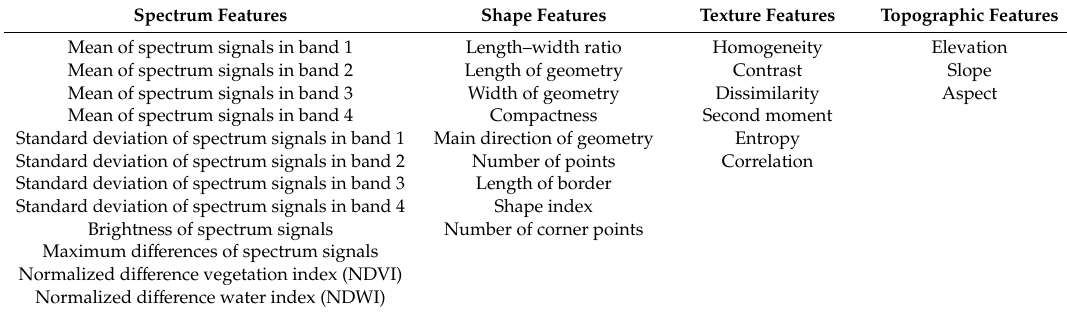
Table 2. List of geo-object features used in